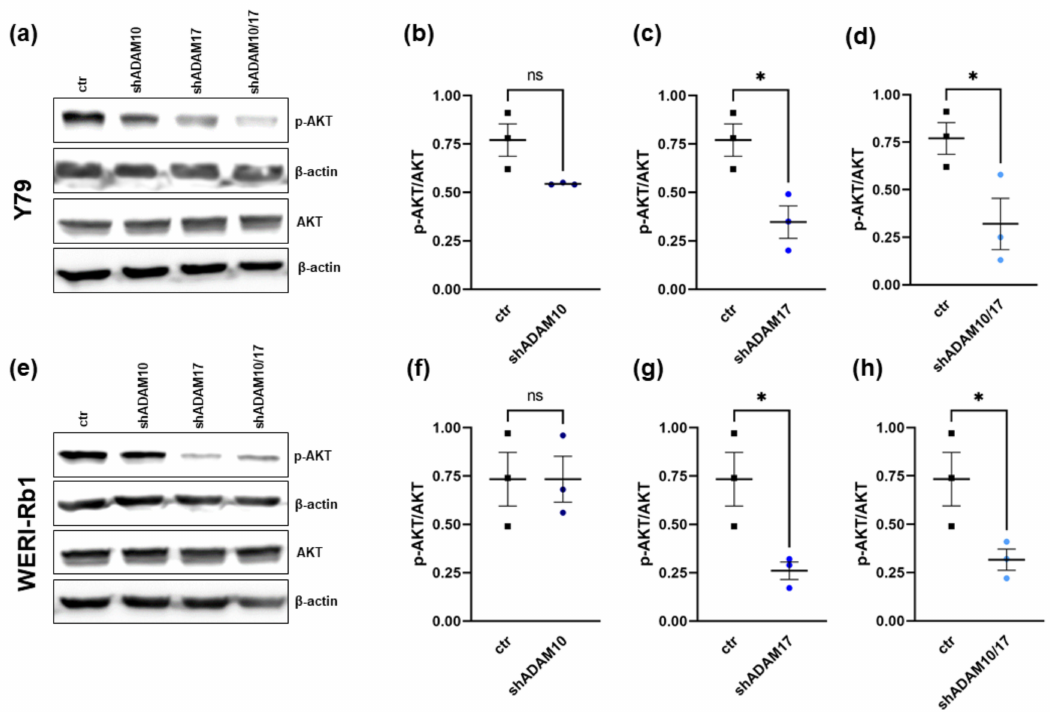
Figure 9. AKT and phospho-AKT (pAKT) expression levels after shRNA-mediated ADAM10/17 single (shADAM10 and shADAM17) or double knockdown (shADAM10/17) in the RB cell lines Y79 and WERI-Rb1 as revealed by western blot analysis. Representative western blots showing AKT and p-AKT expression levels ( a , e ) and quantification of the p-AKT/AKT ratio ( b – d , f – h ) after ADAM10/17 single and double knockdown in the RB cell lines Y79 and WERI-Rb1. Indicated intensity ratios relative to ß-actin, used as a loading control, were calculated using MICRO MANAGER 1.4 software. Values are means of three independent experiments ± SEM. ns p > 0.05 and * p < 0.05 statistical differences compared to the control group calculated by paired Student’s t